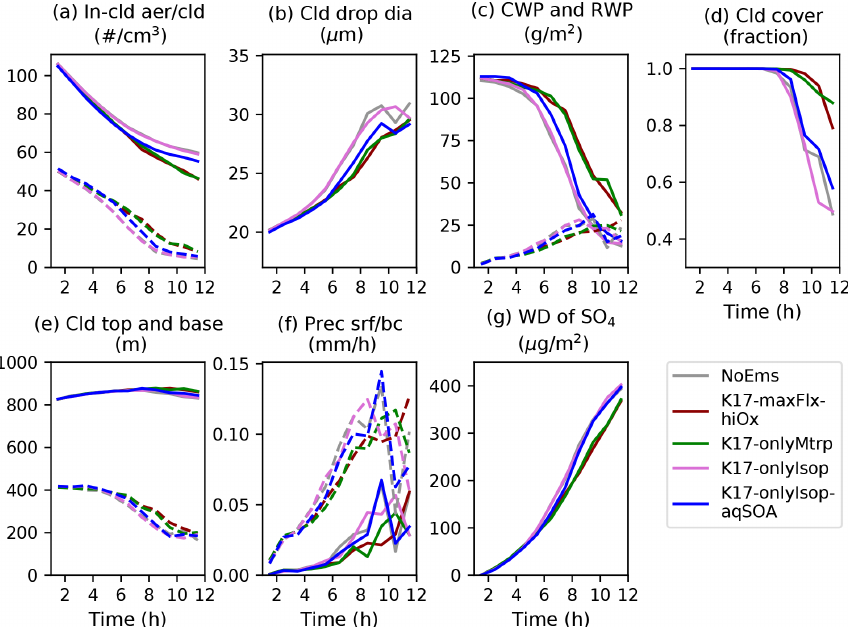
Figure 8. Contributions from monoterpenes and isoprene and impact of including aqueous SOA formation. Grey – no emission; dark red – maximum fluxes of monoterpenes and isoprene emitted, higher oxidant levels; green – only monoterpenes emitted; pink – only isoprene emitted; blue – same as pink but aqueous formation of SOA included.